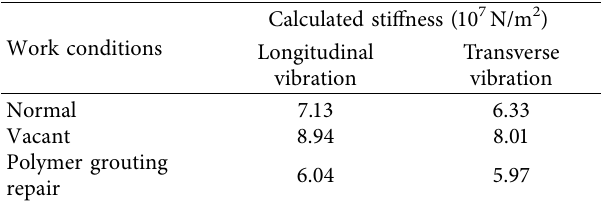
Table 2: Calculated stiffness values for normal, vacant, and